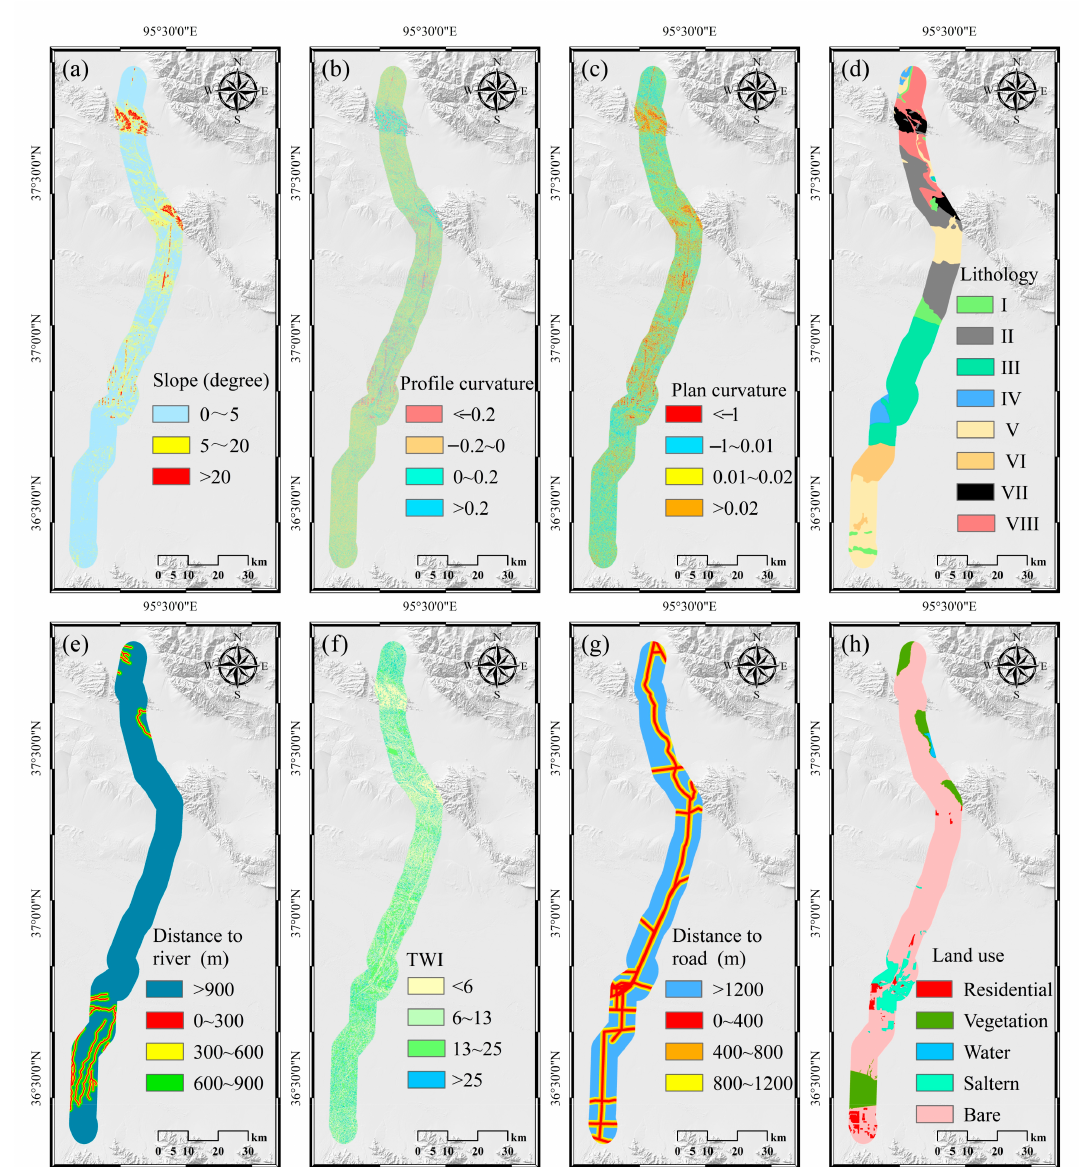
Figure 2. Land subsidence conditioning factors: ( a ) slope; ( b ) plane curvature; ( c ) profile curvature; ( d ) lithology (I Aeolian deposits, II Hard rock, III Chemical deposits, IV Lake sediment, V Flood deposits, VI Marsh sediment, VII Extremely hard rock, VIII Alluvial deposits); ( e ) distance to rivers; ( f ) topographic wetness index (TWI); ( g ) distance to roads; ( h ) land